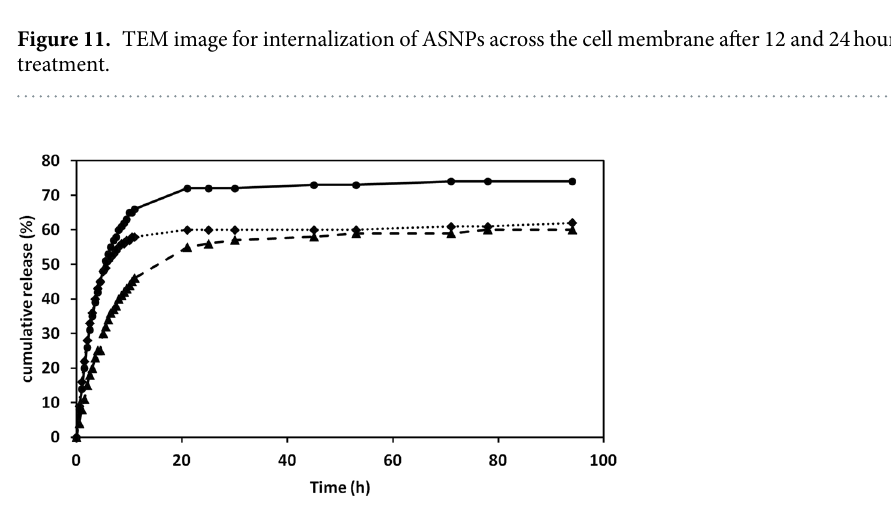
Figure 12. The kinetics of paracetamol release from albumin nanoparticles. The profile of drug release in PBS (pH 7.4) is presented for different concentrations of paracetamol: 5 mg/ml (solid line), 10 mg/ml (dashed line) and 20 mg/ml (dotted line) were used in albumin nanoparticles. Each point is the mean value of three